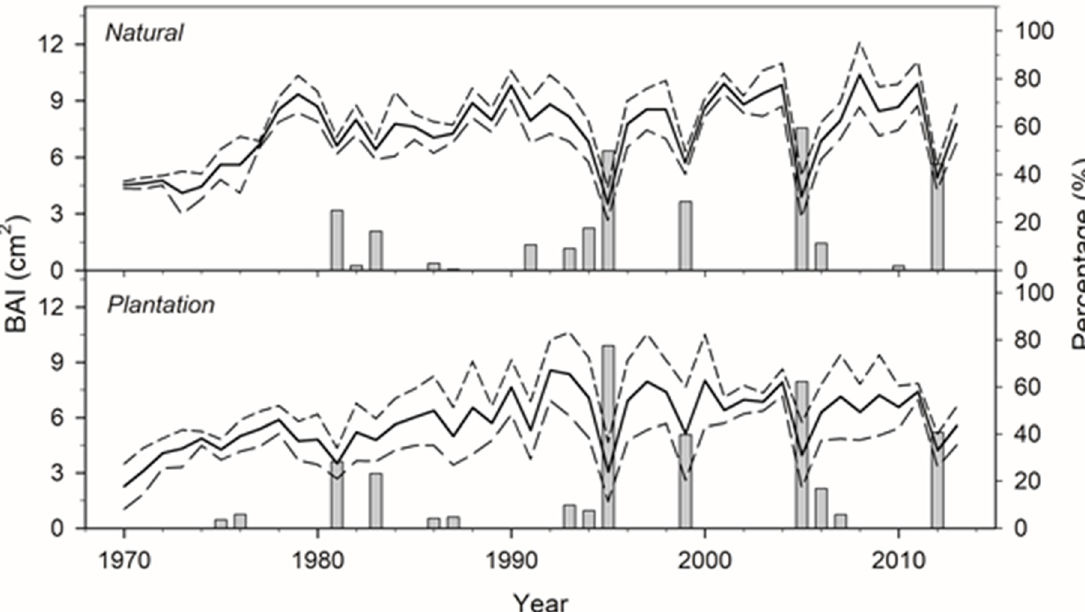
Figure 2. Basal area increments ( ± SD) of Pinus pinaster Ait. for natural forests and plantations (means are shown as continuous lines, SDs as dashed lines). Percentage BAI (basal area increment) growth reduction compared to the growth of the previous three years (grey bars).